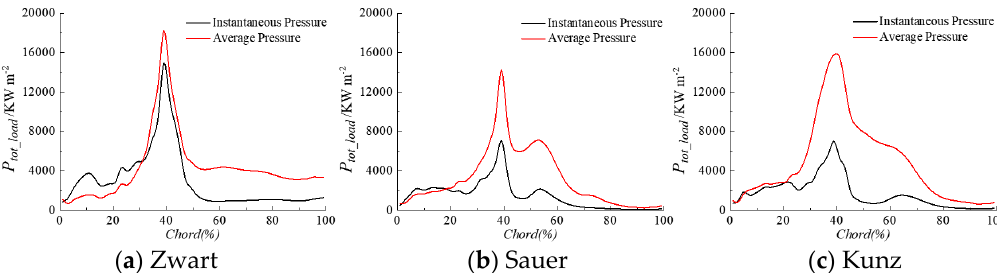
Figure 8. The accumulated total power load during the second shedding cycle predicted using p(t) or p̅ with different cavitation models.